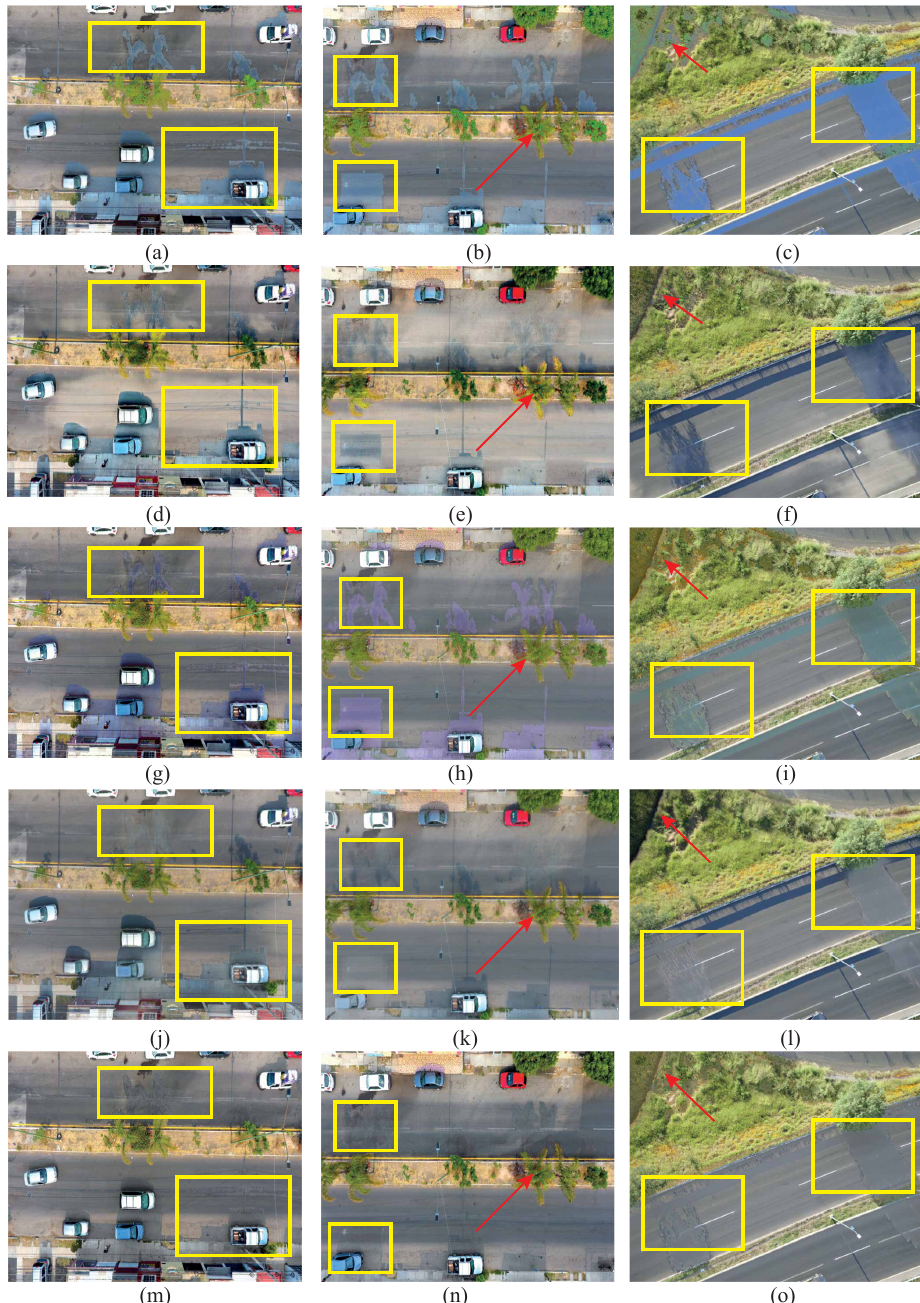
Figure 7. Illumination correction results for study cases 4 ( a ), 5 ( b ), and 6 ( c ); SMGAN method results for study cases 4 ( d ), 5 ( e ), and 6 ( f ); color transfer results for study cases 4 ( g ), 5 ( h ), and 6 ( i ); SynShadow method results for study cases 4 ( j ), 5 ( k ), and 6 ( l ); the proposed method results for study cases 4 ( m ), 5 ( n ), and 6 ( o